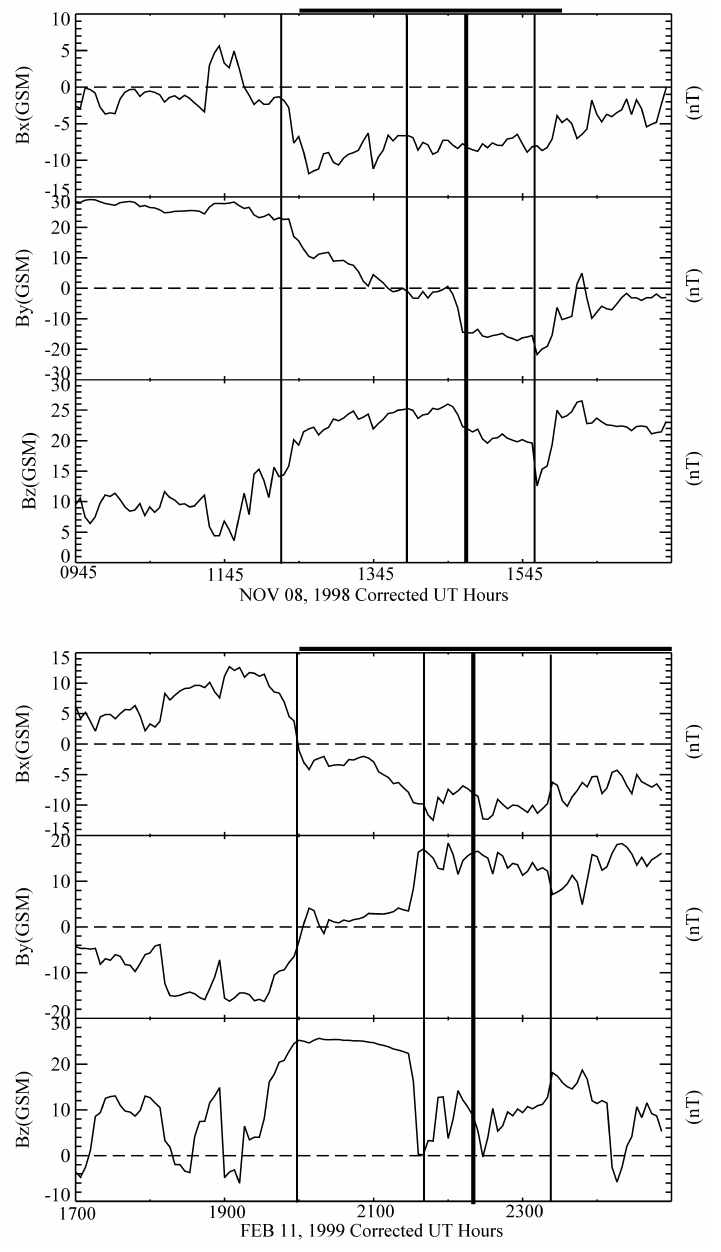
Fig. 1. Shown are magnetic field data from the ACE satellite which orbits the L1 Lagrange point about 200 R E sunward of the Earth. IMF GSM components are plotted for our two examples, with 8 November 1998 at the top and 11 February 1999 at the bottom, as a function of corrected universal time (UT plus the estimated propagation time from the satellite to GSM X = 0); in the top panel (8 November 1998) about 45min and in the bottom panel (11 February 1999) about 1h. The thickest vertical line in each plot marks the time when the TPA is aligned along the noon-midnight meridian. The three additional lines mark the time when the DMSP F13 satellite reaches its highest magnetic latitude over the Northern Hemisphere during each orbit. The thick horizontal line at the top of each panel denotes the time period of UVI data shown in Figs. 2 and